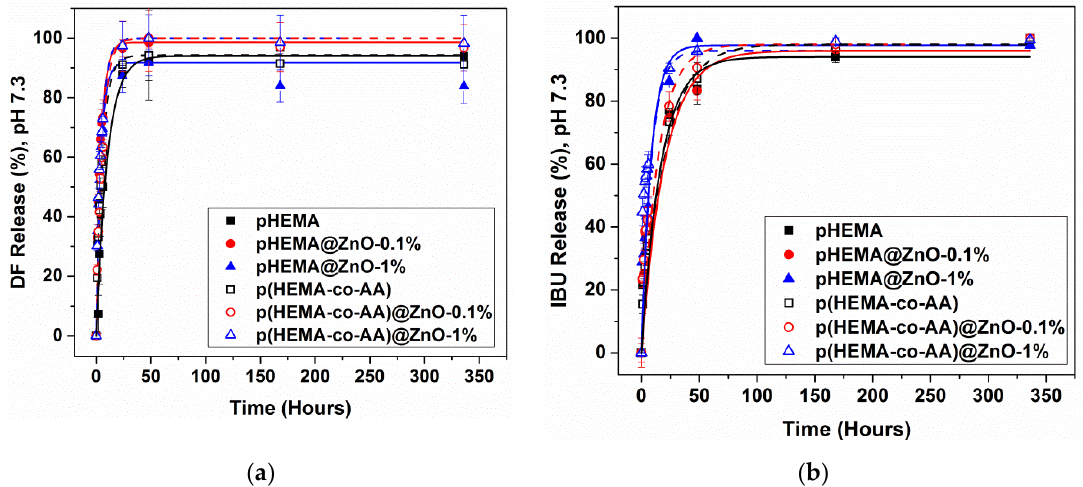
Figure 8. Kinetic of drug release during time, in physiological artificial urine solution: ( a ) diclofenac and ( b ) ibuprofen, both in sodium salts form. Experimental points are reported along with their error bars. All of the experimental points follow a pseudofirst-order kinetic law. Fitting curves are represented by plain lines for pHEMA-based samples and by dashed lines for p(HEMA-co-AA)-based samples. Table 1. Kinetic parameters for DF and IBU drug release at physiological pH conditions.